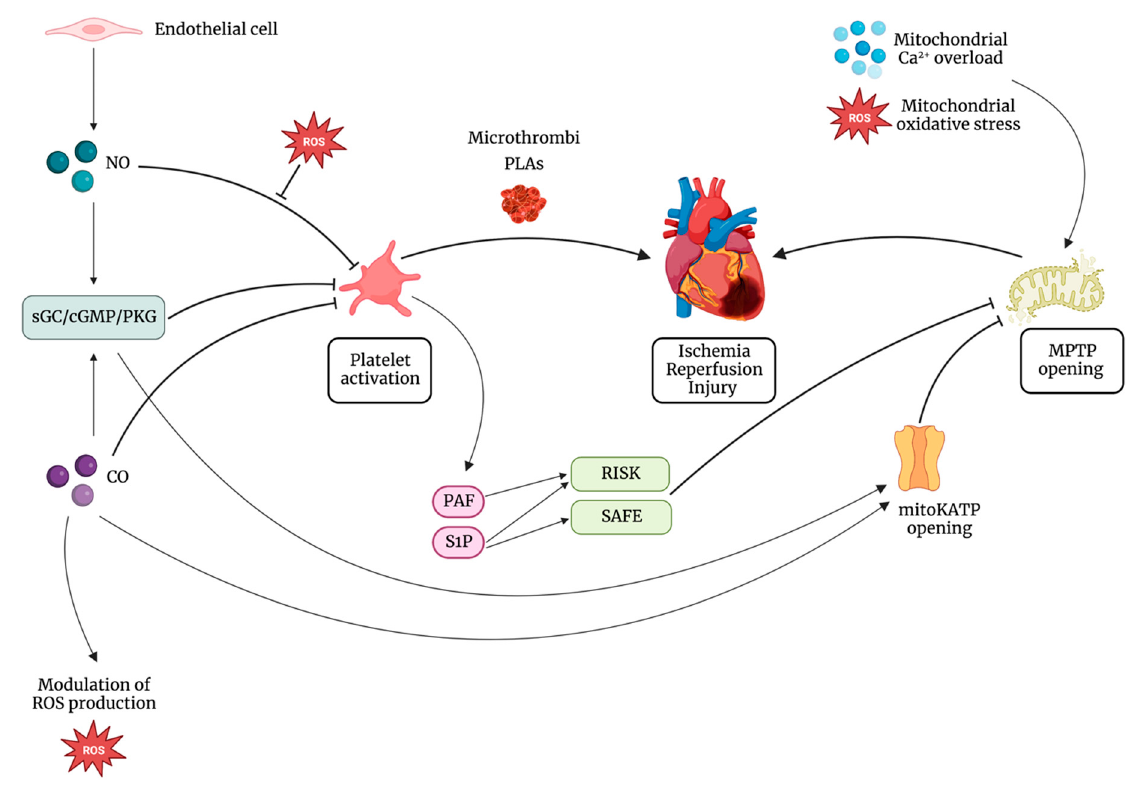
Figure 2. Mitochondrial permeability transition pore (MPTP) opening is the main end effector in ischemia reperfusion injury (IRI). On one side, platelets contribute to IRI mainly by microthrombi formation and platelet-leukocyte aggregates (PLAs). On the other side, molecules of platelet origin, such as platelet activating factor phosphoglyceride (PAF) and sphingosine-1-phosphate (S1P), lead to the activation of cardioprotective pathways, such as the reperfusion injury salvage kinase (RISK) pathway and the survivor activating factor enhancement (SAFE) pathway, all targeting inhibition of MPTP opening. Besides, the interaction between platelets and gasotransmitters has a central role in cardioprotection. Nitric oxide (NO) activates the soluble guanylate cyclase (sGC)/cyclic guanosine monophosphate (cGMP)/cGMP-dependent protein kinase (PKG) pathway, leading to the inhibition of platelet adhesion, activation, and aggregation. NO can inhibit platelet response also by cGMP-independent mechanisms. NO inhibitory effect on platelets is reduced in the presence of increased levels of reactive oxygen species (ROS). Also, PKG leads to the opening of the mitochondrial ATP-dependent K+ channel (mitoKATP) and subsequent inhibition of MPTP. Carbon monoxide (CO) exerts its cardioprotective action triggering the opening of mitoKATP with consequent inhibition of the opening of MPTP and modulating mitochondrial ROS production. Furthermore, it can inhibit platelet activation both by cGMP-dependent and cGMP-independent mechanisms.